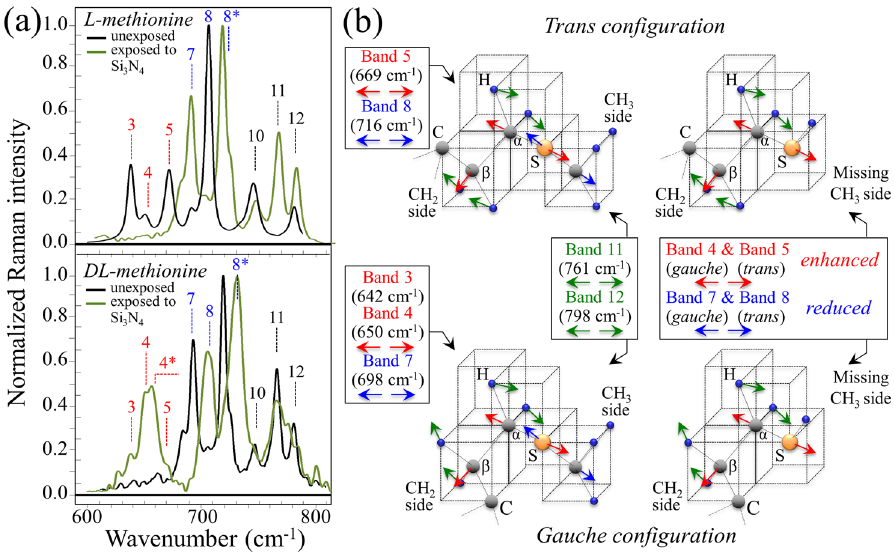
Figure 9. ( a ) Raman spectra of L- and LD- methionine polymorphs in aqueous solution with and without 15 wt.% Si 3 N 4 dispersion; spectra were collected in the frequency interval 600–800 cm −1 (vibrational modes are given by labels in inset); and, ( b ) schematic drafts of the trans and gauche methionine structures before and after interaction with the Si 3 N 4 powder with a representation of the main vibrational modes (band labels in inset refer to labels in Fig. 8 and to the vibrational modes given in Table